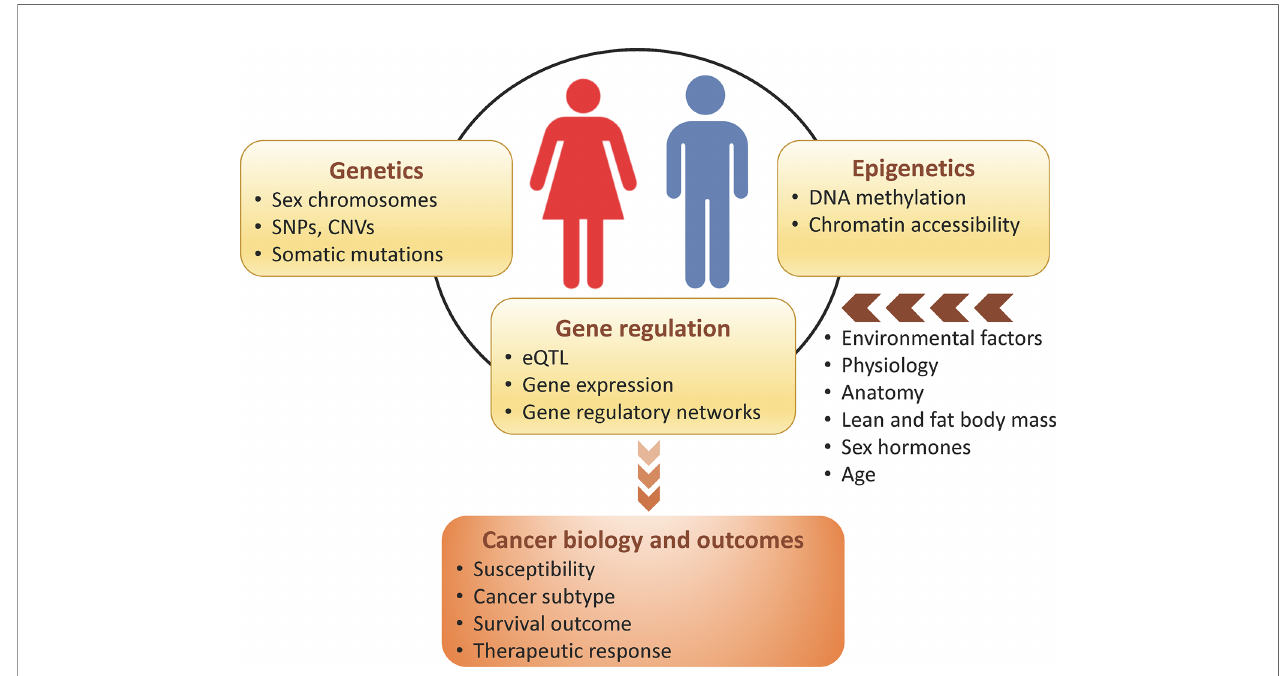
FIGURE 2 | Sex differences in genomics, which can be modulated by host and environmental factors, in fl uence cancer biology and